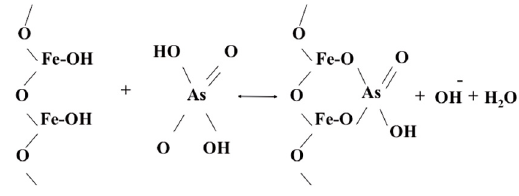
Figure 6: Proposed mechanism of arsenic adsorption process by MNPs 37-39 . Table 3: Experimental conditions employed in the contact adsorption tests for calculating the adsorption capacity. C (mg L -1 ) 0